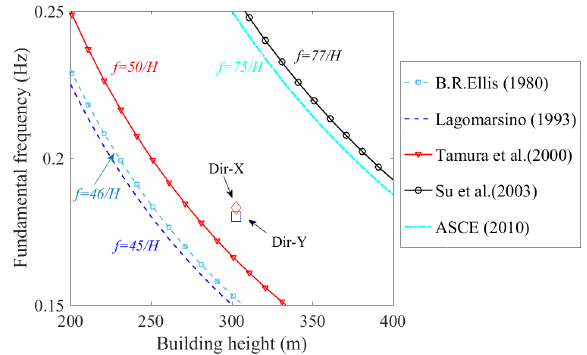
Figure 12. Correlation between the building fundamental frequencies with building height and existing prediction models.